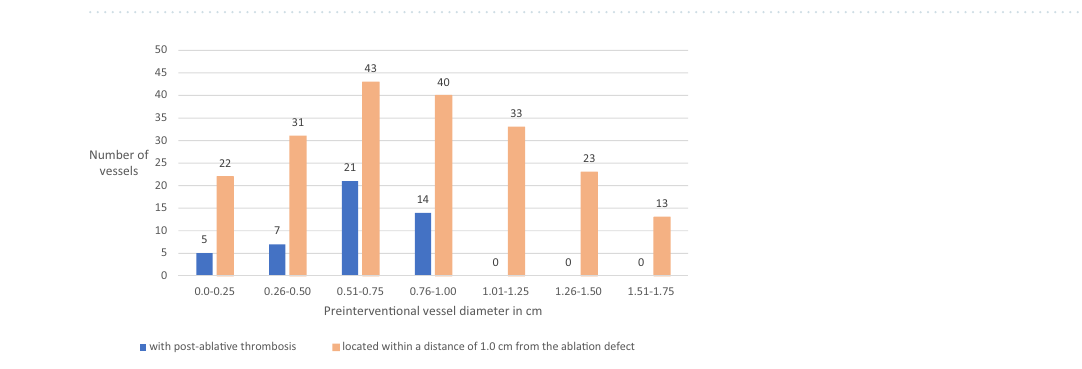
Table 5. Results of binary logistic regression model predicting delayed thrombosis, i.e., thrombosis occurring 6 weeks to 3 months after